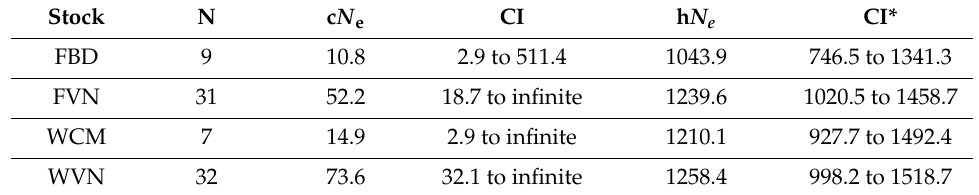
Table 4. E ff ective population size over catfish stocks for farm vs. wild fish, country and region